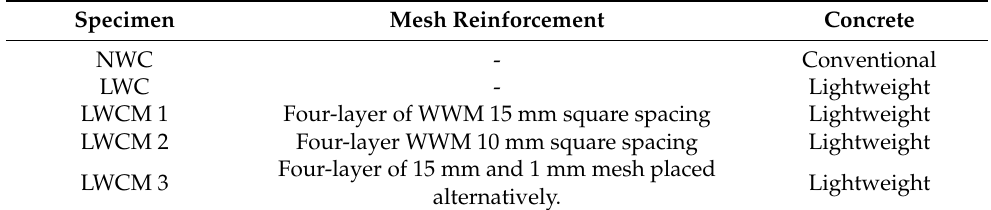
Figure 3. WWM tied to steel rebar. Table 6. Details of specimen.